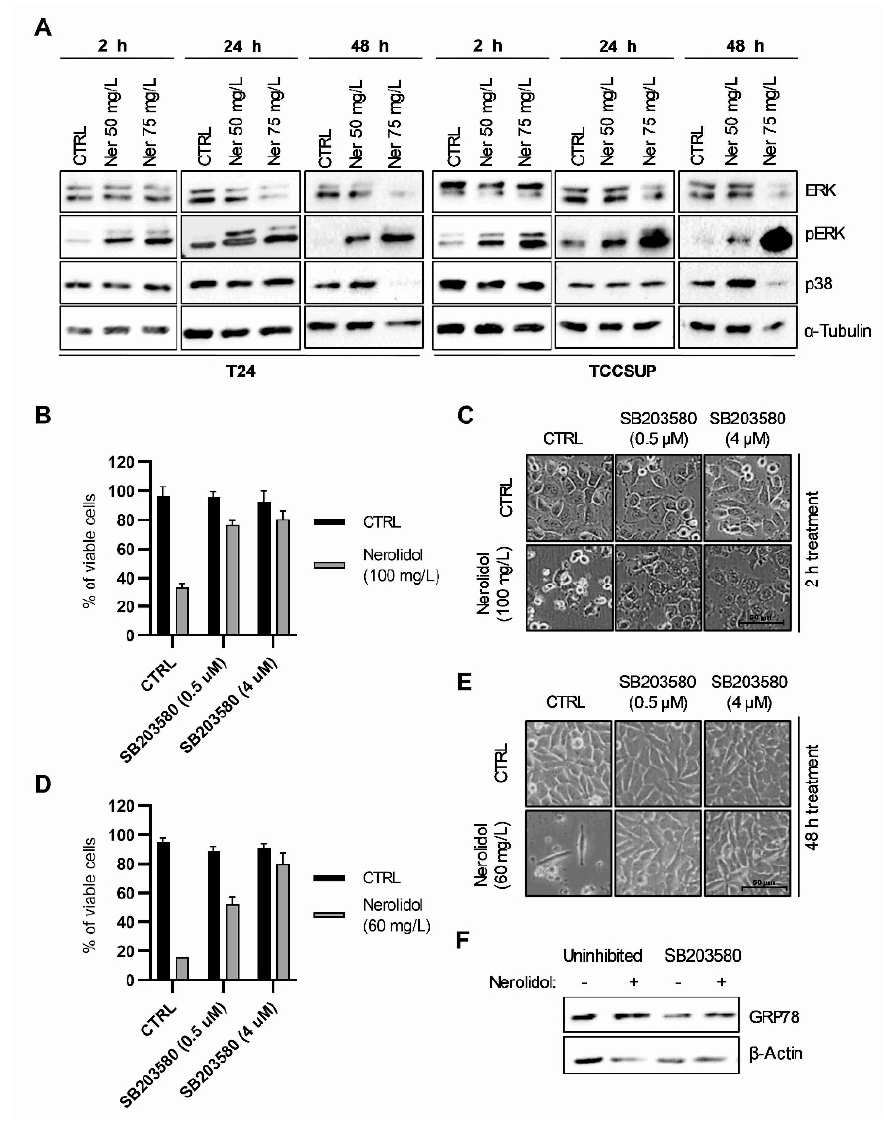
Figure 5. Nerolidol cytotoxicity is driven through MAPKs. ( A ) Immunostaining of ERK, pERK, and p38 on T24 (left) and TCCSUP (right) cells after treatment with 50 and 75 mg/L of nerolidol for 2, 24, and 48 h. α -tubulin was used as a loading control. ( B ) Cell viability of T24 cells pre-treated with SB203580 (0.5 and 4 µ M) for 1 h and then treated with 100 mg/L of nerolidol for 2 h determined by cell counting and trypan blue staining. Cell counts were normalized to control cells. ( C ) Cell microscopy images of T24 cells pre-treated with SB203580 (0.5 and 4 µ M) for 1 h and then treated with 100 mg/L of nerolidol for 2 h. ( D ) Cell viability of T24 cells pre-treated with SB203580 (0.5 and 4 µ M) for 1 h and then treated with 60 mg/L of nerolidol for 48 h determined by cell counting and trypan blue staining. Cell counts were normalized to control cells. ( E ) Cell microscopy images of T24 cells were pre-treated with SB203580 (0.5 and 4 µ M) for 1 h and then treated with 60 mg/L of nerolidol for 48 h. ( F ) T24 cells treated with SB203580 (4 µ M) for 1 h before nerolidol (60 mg/L) administration and incubated for 24 h. Immunostaining of GRP78 was used to test the effect on ER stress induction. The uncropped blots and molecular weight markers are shown in Supplementary File